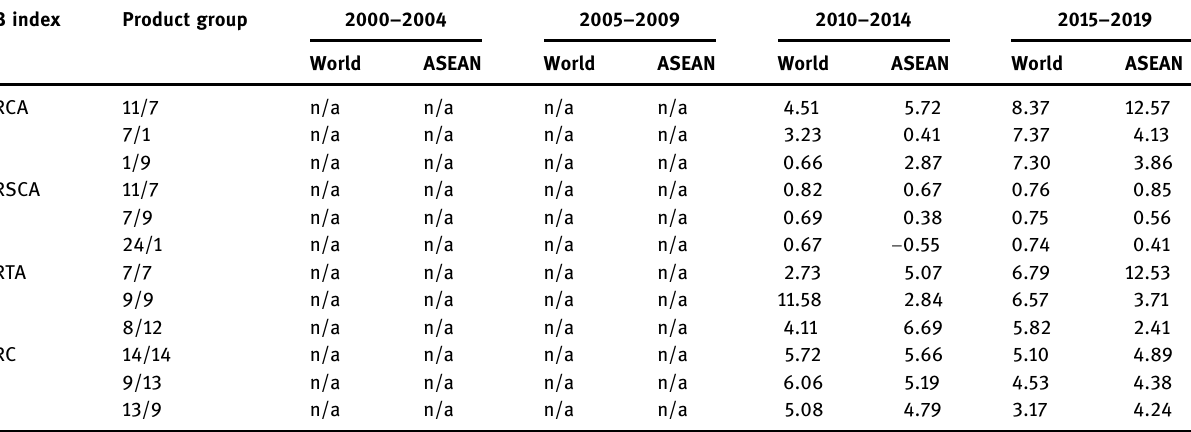
Table 7: The three highest Balassa indices of Laos at World and ASEAN level, 2000 – 2019